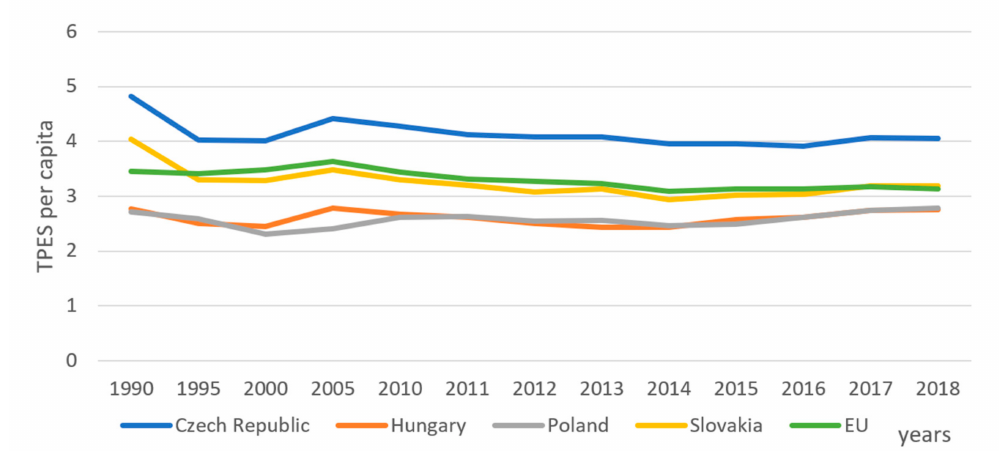
Figure 5. Energy intensity (TPES per capita) in the Visegrad Group countries in